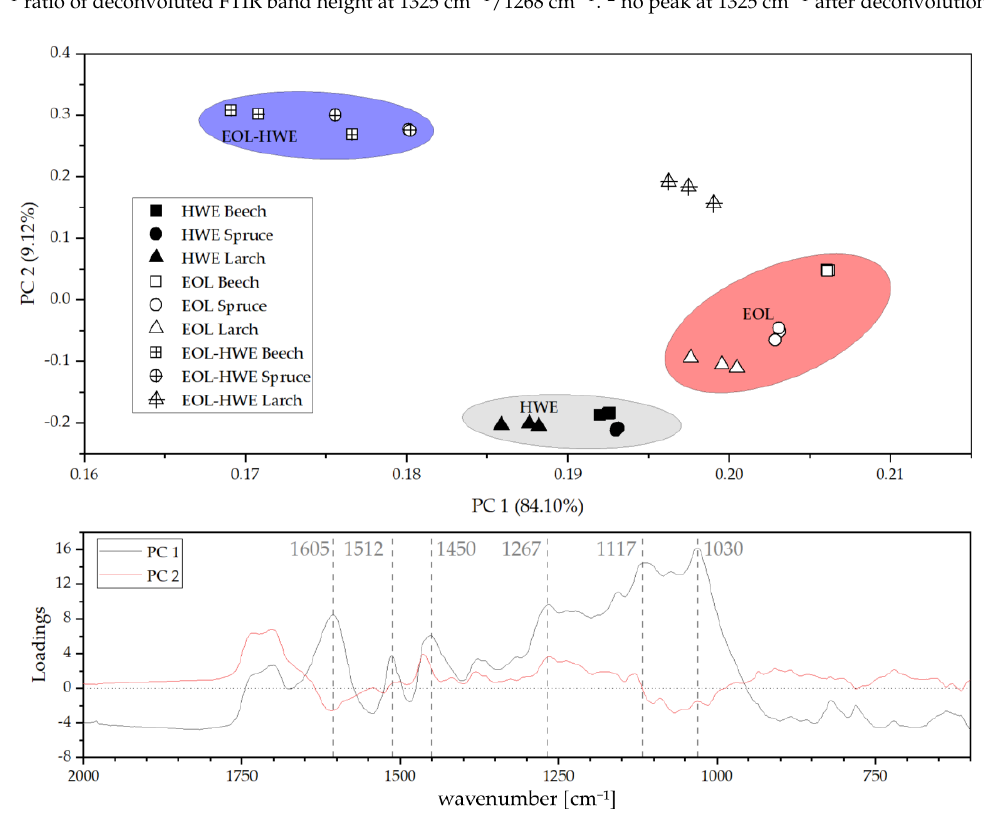
Figure 7. Chromatograms of extracted organosolv lignin with and without pretreatment. While the identified peaks from the hot water extracts (HWE) are mostly assigned to flavonoids and flavonoid glycosides, a majority of compounds identified in the organo- solv fractions (EOL and EOL–HWE) consist of different organic acids. If no hot water